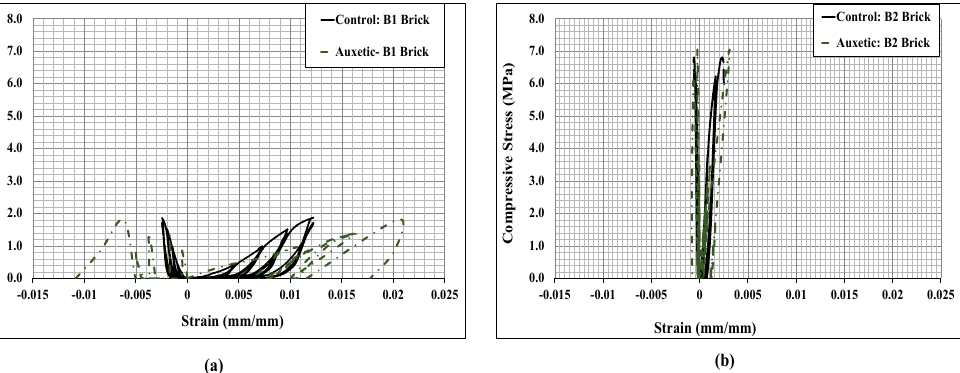
(0.005) compared to the B1 bricks wallettes (strain = 0.02) due to the stiff and brittle nature of the B2 bricks.